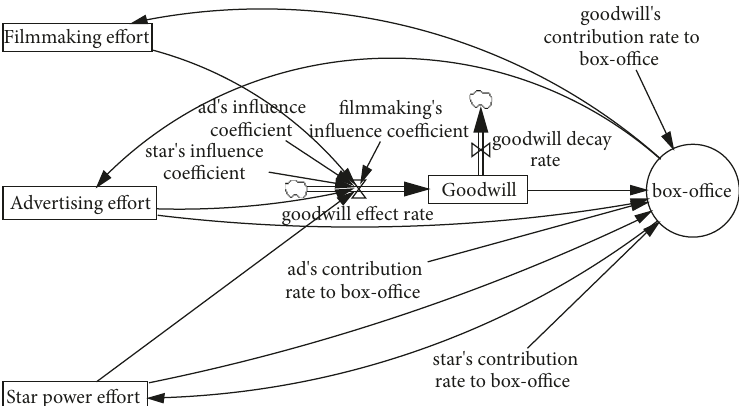
Figure 7: Stock and flow diagram for film goodwill.